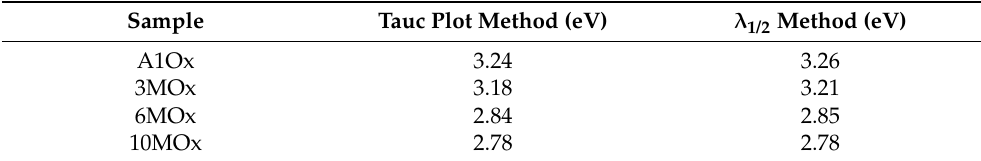
Table 2. Fundamental optical bandgaps of the ZnO films, determined by two distinct methods.